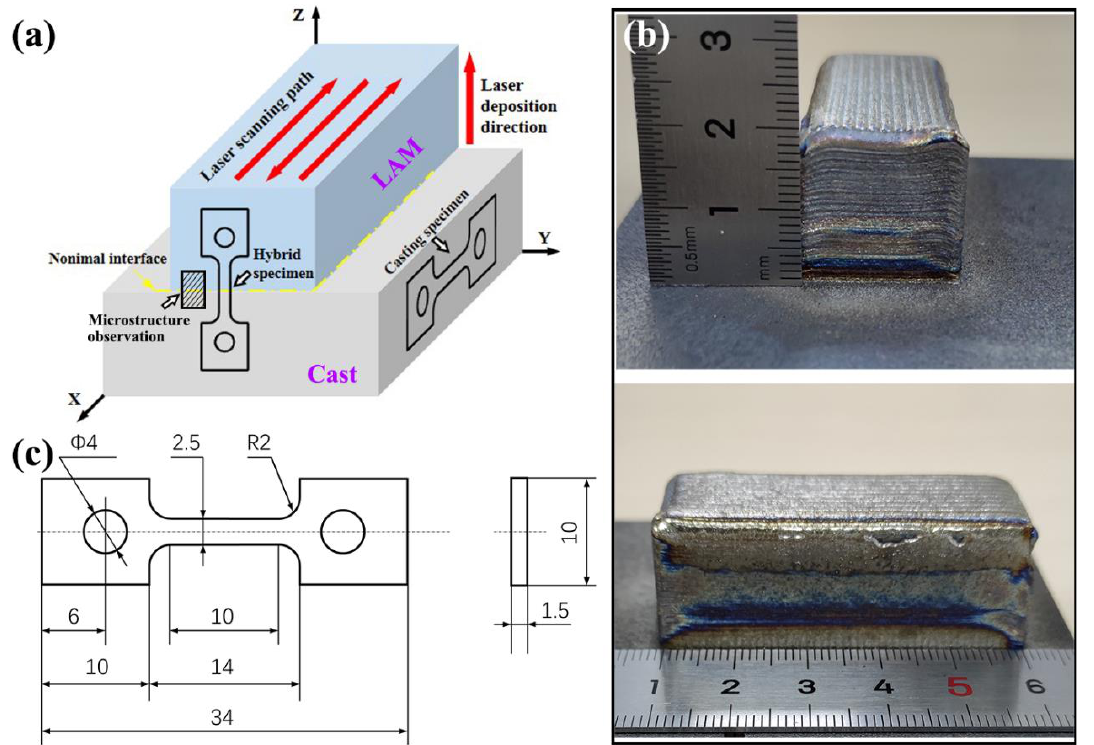
Figure 1. ( a ) Schematic illustration of the hybrid fabricating process and the sampling positions for microstructure observation and tensile test, ( b ) the hybrid manufactured TC4 sample, ( c ) schematic illustration of the tensile specimen.